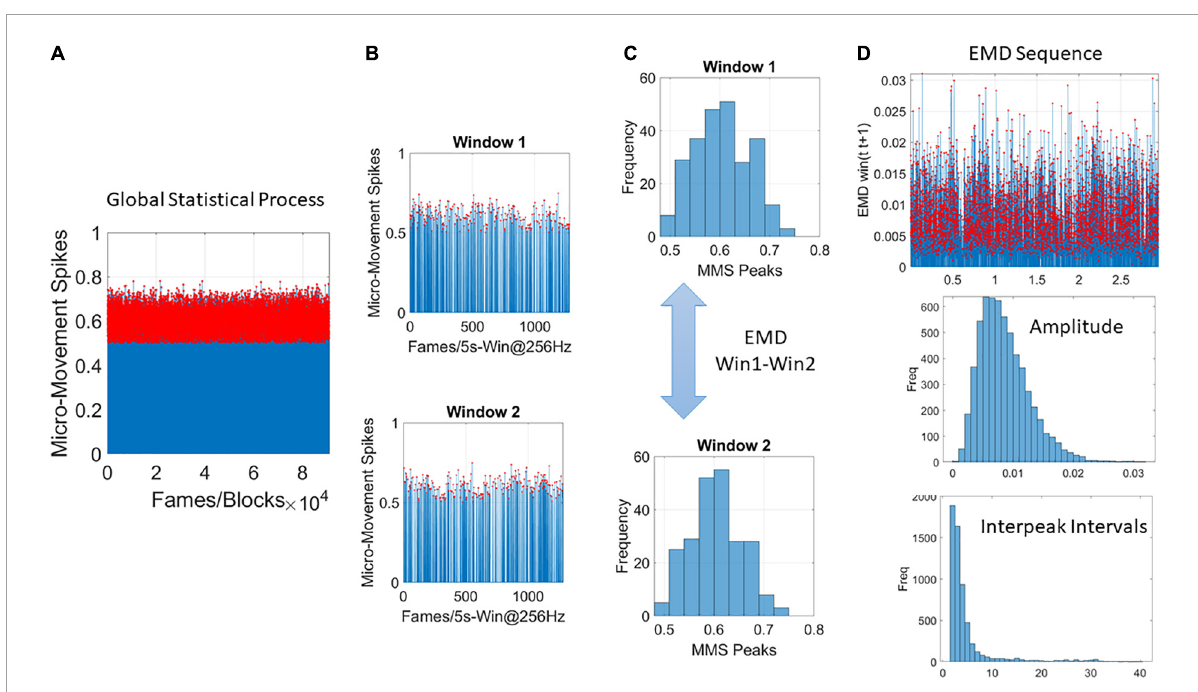
FIGURE4 Global analyses (A) performed by pooling the MMS across trials and blocks and taking 5-s-long windows with 50% overlap (B) to obtain frequency histograms that can be compared using the EMD metric (C) . (D) Sweeping through the full trajectory of a condition gives the EMD sequence to obtain the peaks in red and gather them into a frequency histogram tracking the fluctuations in amplitude of the EMD variation (i.e., how the distribution change shape and dispersion) and the rate at which these changes occur as the inter peak interval intervals measuring the distances as well across peaks representing the PDF transitions. These histograms are used in MLE estimation of the distribution parameters best describing this global